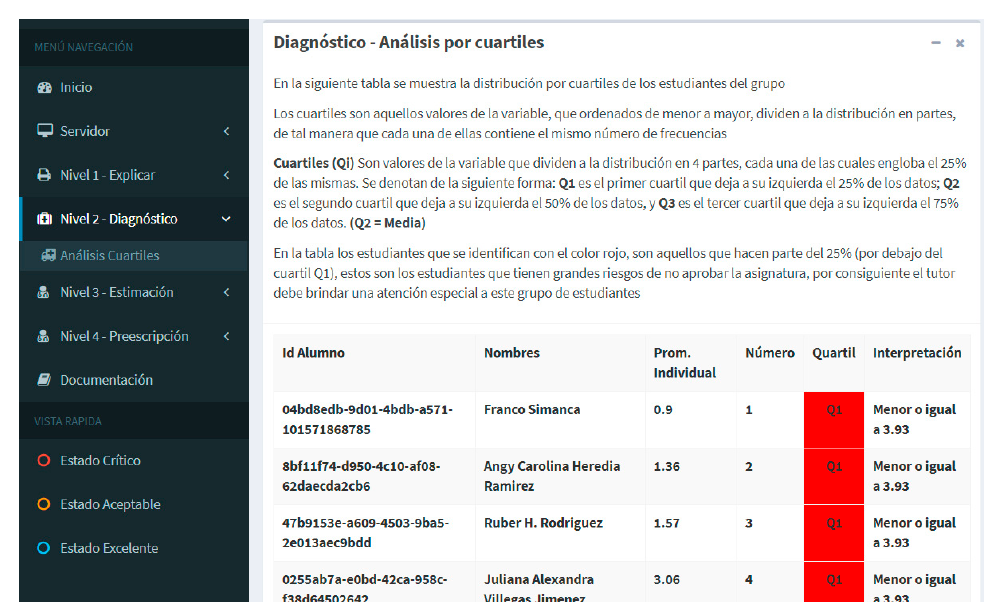
Figure 4. ( a ) First-level learning analytics (LA) options, based on data from the virtual classroom. ( b ) Detail of the total connection times for each student in the virtual classroom. ( c ) The individual performance of each student vs the group average (an individual average in red indicates the student falls below the group average).